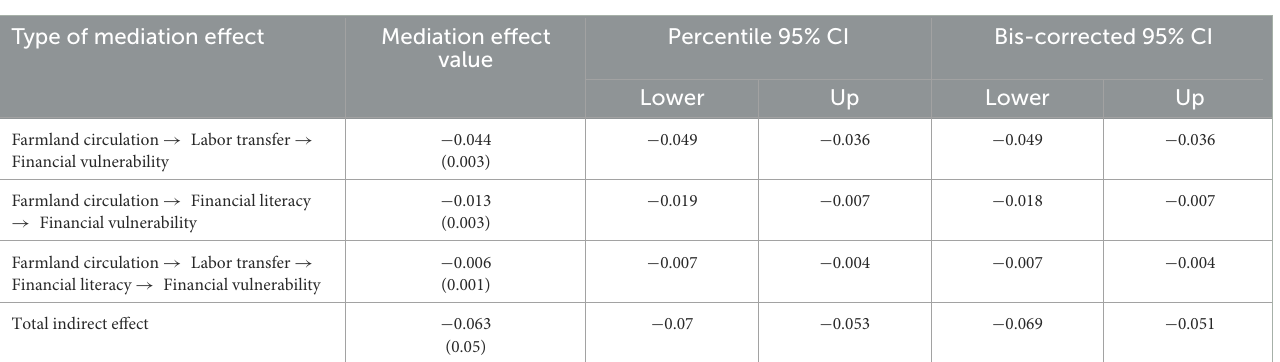
TABLE 7 Bootstrap intermediation effect test